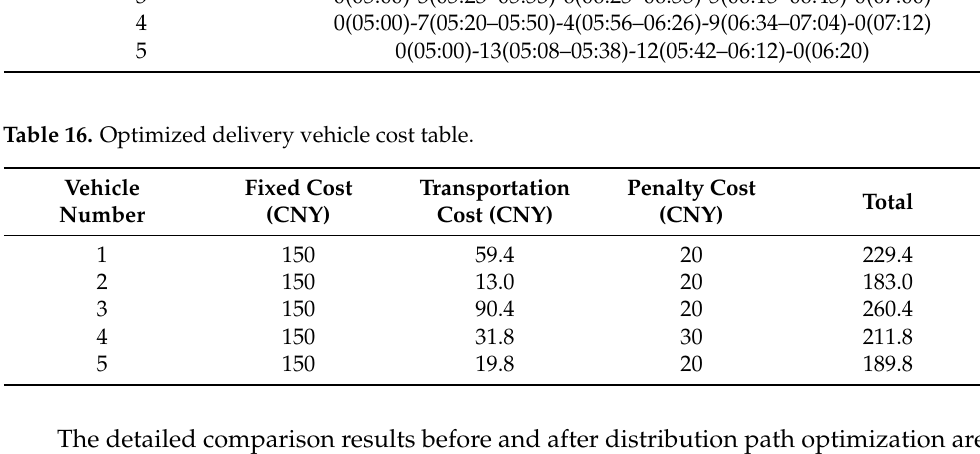
The detailed comparison results before and after distribution path optimization are shown in Table 17. Table 17. Comparison table of results before and after optimization. Before After Optimization Optimization